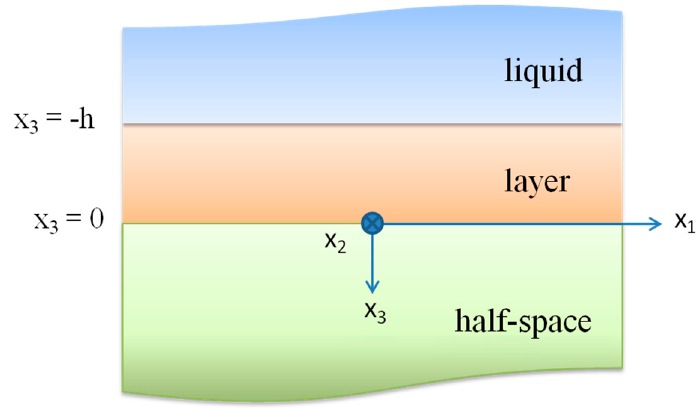
Figure 10. The geometry of the Love wave waveguide. The layer upper surface ( x 3 = − h ) is in contact with the viscous liquid.